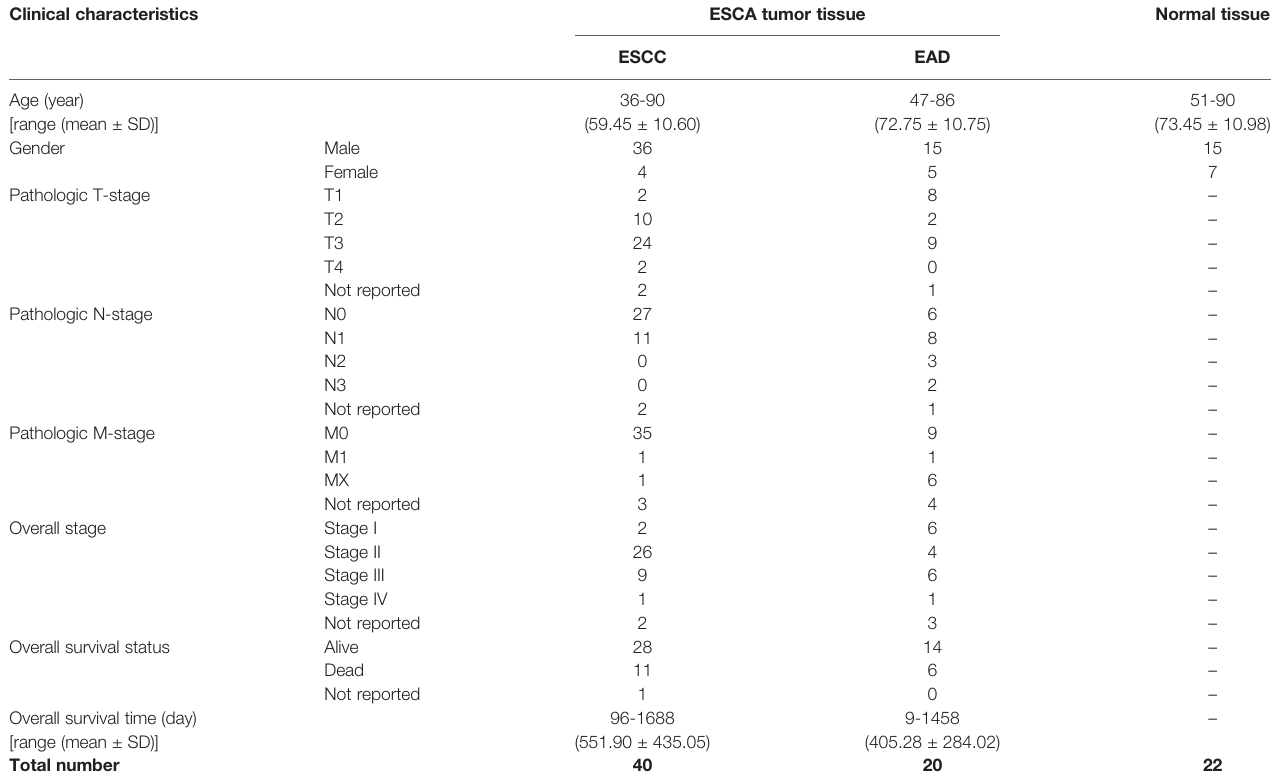
TABLE 1 | Clinical characteristics of cases in this study (information derived from the TCGA